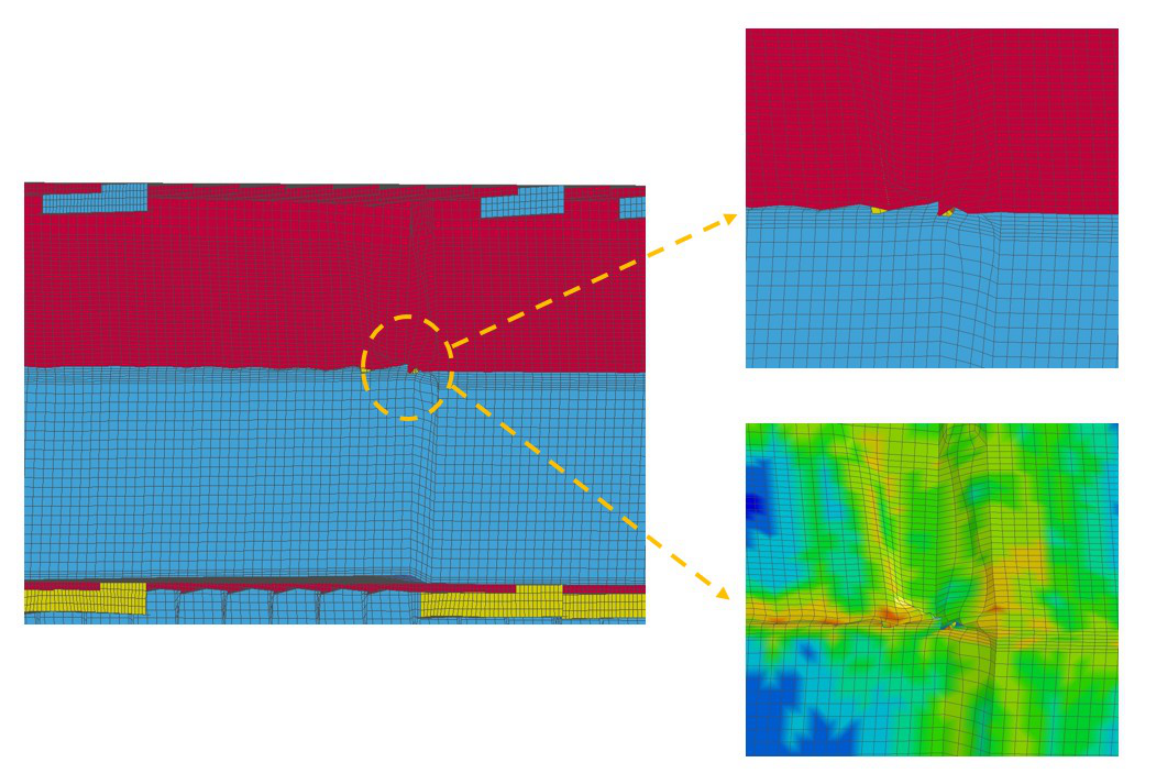
Figure 19: Deformation on DSS inner skin after collision on outer skin structure-